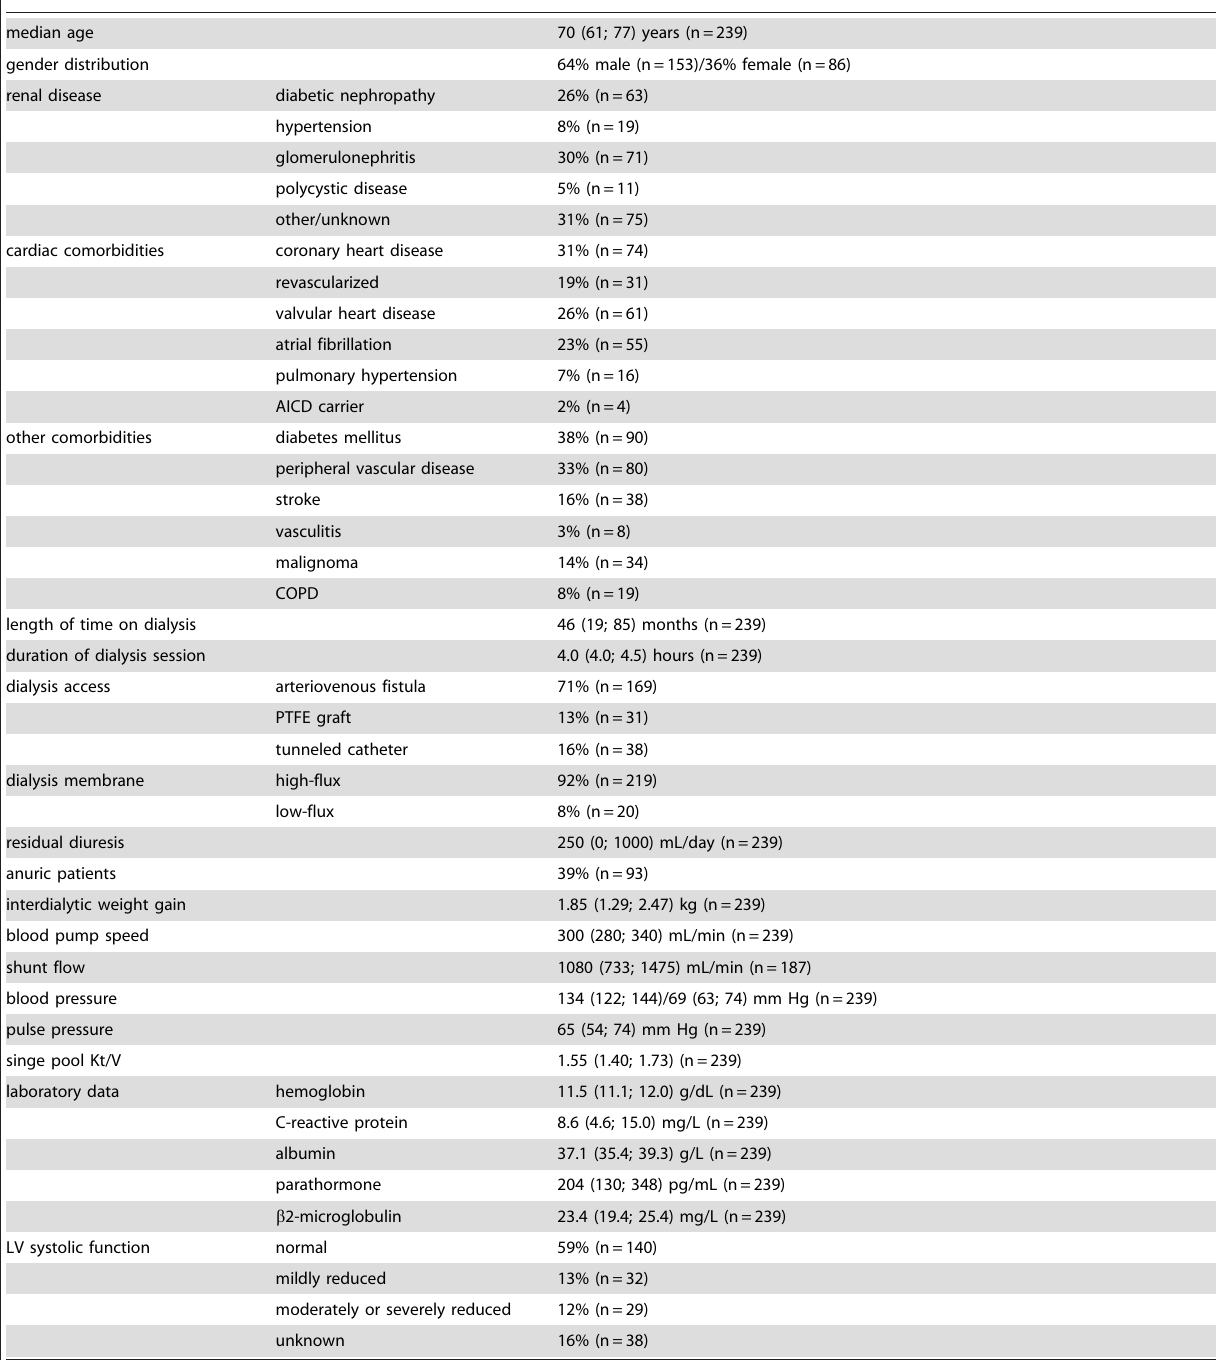
Table 1. Patient characteristics of the cohort (n